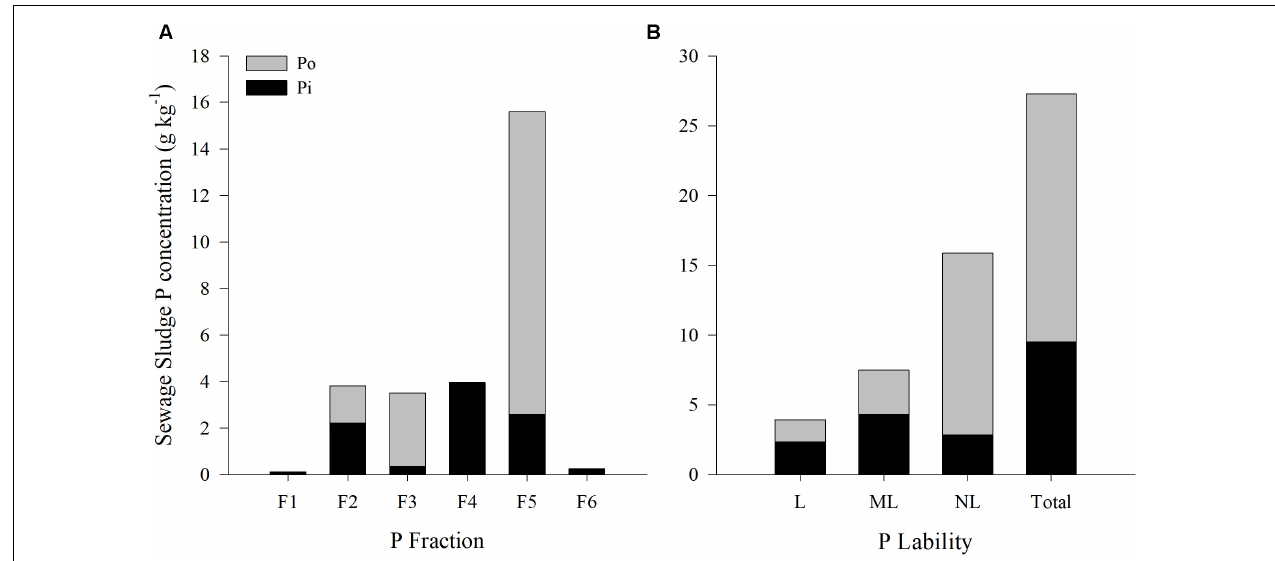
FIGURE 1 | Fractionation (A) and lability (B) of phosphorus in the class B sewage sludge used in the Eucalyptus planting area. P o , organic phosphorus; P i , inorganic phosphorus; F1, P extracted by water; F2, P extracted by 0.5 mol L − 1 sodium bicarbonate; F3, P extracted by 0.1 mol L − 1 sodium hydroxide; F4, P extracted by 1 mol L − 1 hydrochloric acid; F5, P extracted by 0.5 mol L − 1 sodium hydroxide; F6, residual P; L, Labile (F1 + F2); ML, moderately labile (F3 + F4); NL, non-labile (F5 + F6) ( n =